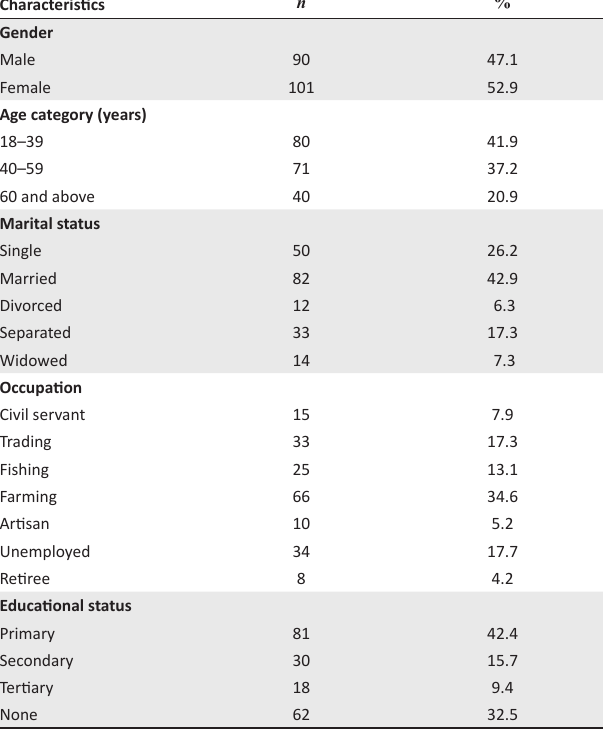
TABLE 1: Demographic characteristics of participants ( n =